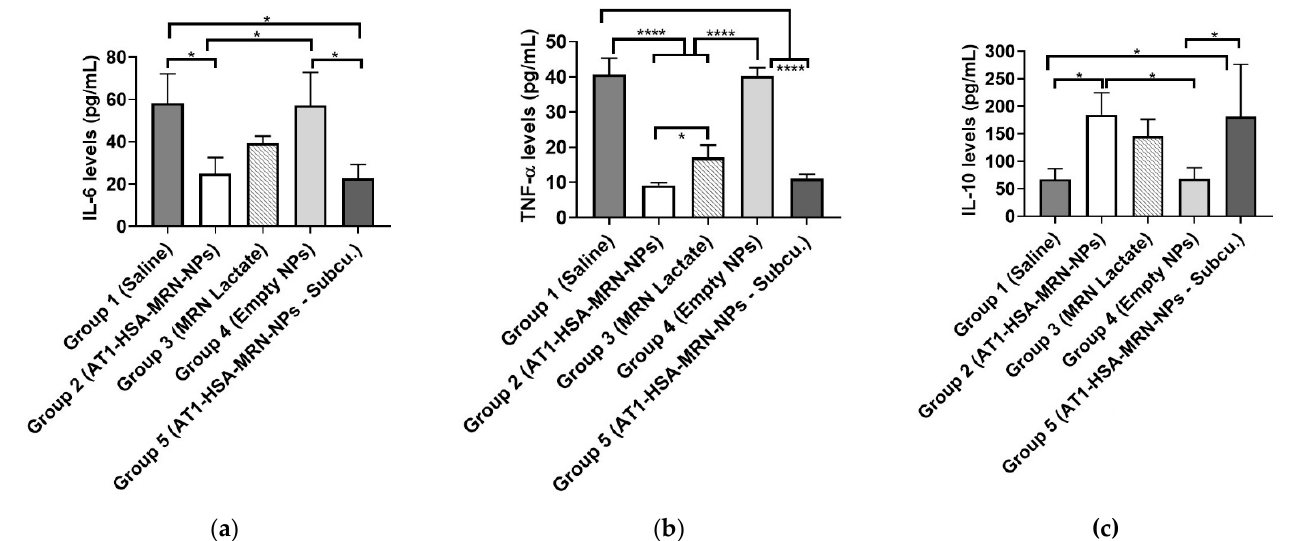
Figure 11. Serum cytokine levels for ( a ) IL-6 (pg/mL), ( b ) TNF- α (pg/mL), and ( c ) IL-10 (pg/mL). Groups 2 and 5 had significantly lower levels of IL-6 and TNF- α and significantly higher levels of IL-10 compared with other groups. The data have been presented as mean ± SD ( n = 5). **** p < 0.0001 was considered highly significant and * p < 0.05 was considered significant based on Tukey’s post hoc analysis.